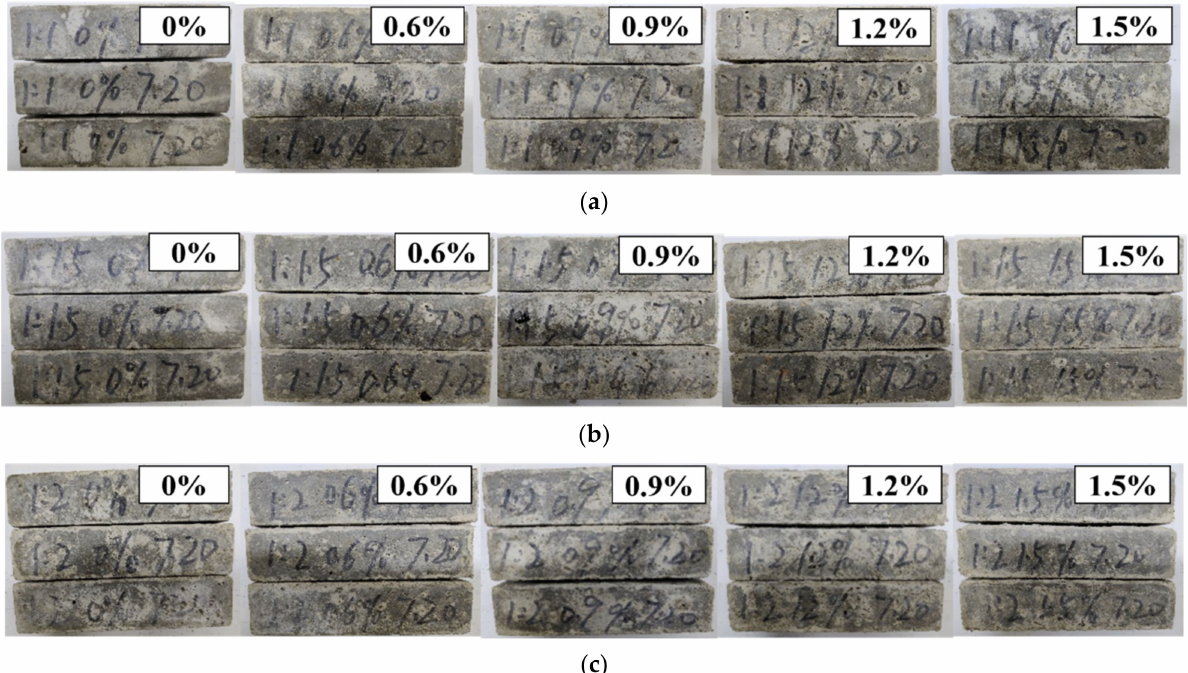
Figure 5. Appearance of PP fiber mortar specimens treated with different C/S values and different dosages after 150 dry-wet cycles: ( a ) 1:1; ( b ) 1:1.5; ( c ) 1:2.